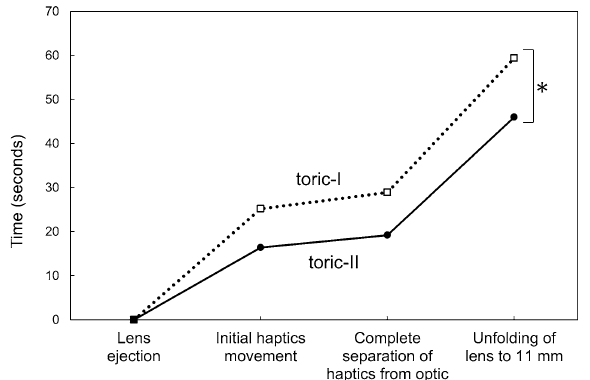
Figure 2. Elapsed time for each unfolding step of toric intraocular lenses. After the lens was ejected from the injector, the haptics started to move earlier with toric-II than with toric-I IOLs. Thereafter, the unfolding process of both toric IOLs were similar and the time course was parallel. The overall time from IOL ejection to unfolding to 11 mm was significantly longer with toric-I than with toric-II IOLs (p =